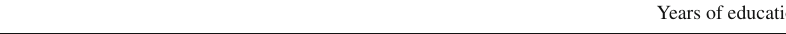
Table 6 First-stage results